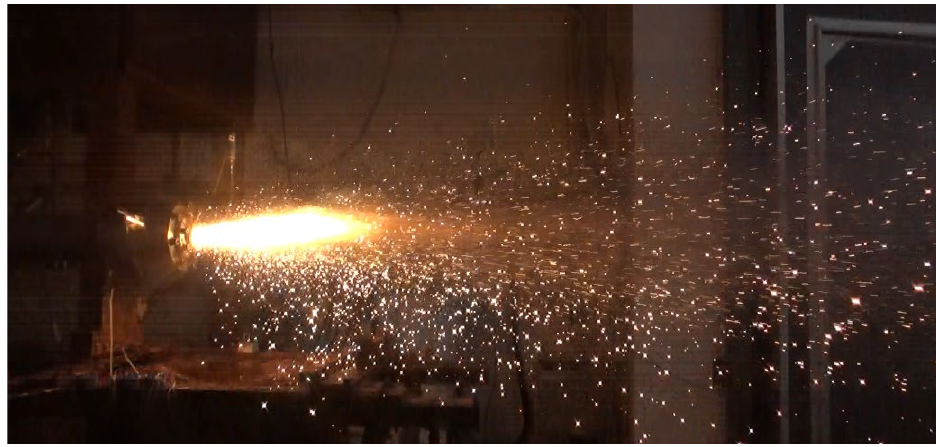
Figure 14. Photograph of the firing test.